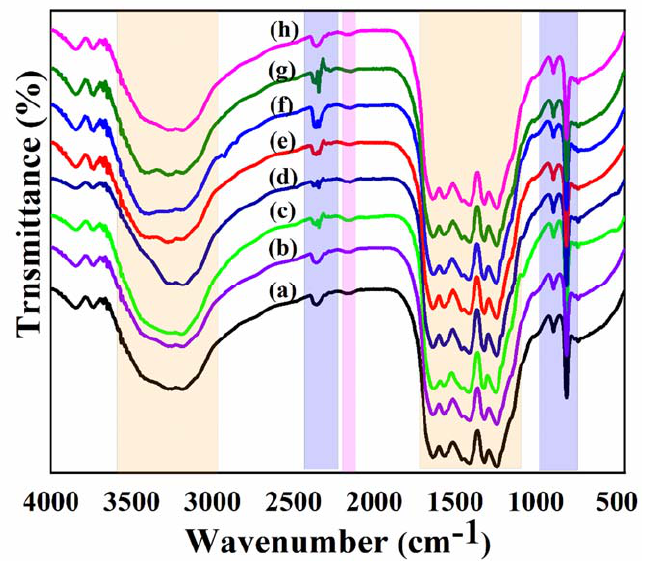
Figure 4. FTIR spectra of ( a ) MCN ‐ 1H, ( b ) MCN ‐ 2H, ( c ) MCNC, ( d ) 0.5 Fe ‐ MCNC, ( e ) 1Fe ‐ MCNC, ( f ) 2Fe ‐ MCNC, ( g ) 3Fe ‐ MCNC, and ( h ) 4Fe ‐